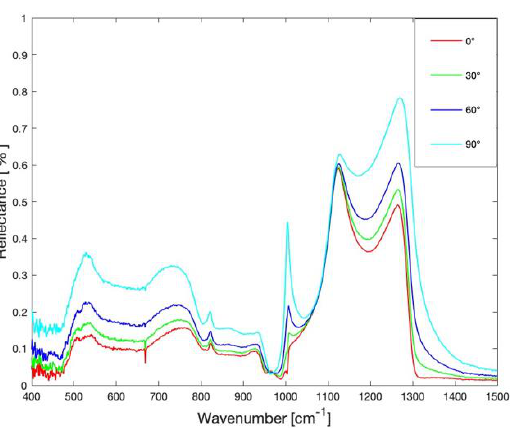
Fig. 1. FTIR reflection spectrum measured at an angle of incidence of 45° as a function of the different input polarization on MoO 3 film 500 nm-thick, grown by PLD on fused silica substrate, T=500°C, P O2 =10 -1 mbar.